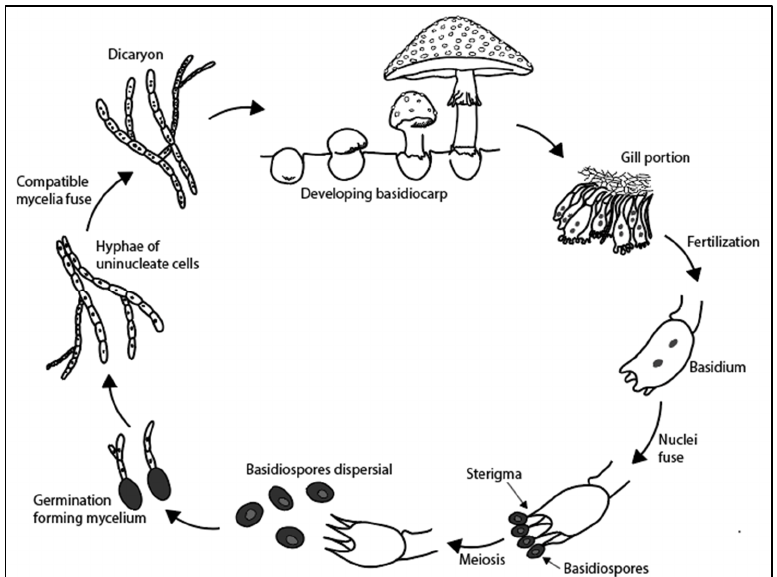
Figure 6. Generalised basidiomycetes’ sexual reproduction cycle (adapted after Taylor et al. [28]). Basidiospores are reproductive spores produced by Basidiomycetes. The dicaryon is mycelium that contains cells with two nuclei. Basidiocarp is a multicellular structure from which the hymenium and subsequently spores are produced. The gill portion is the hymenophore rib found under the cap of the mushroom. The basidium is where basidiospores are produced and the sterigma is the supporting structure.